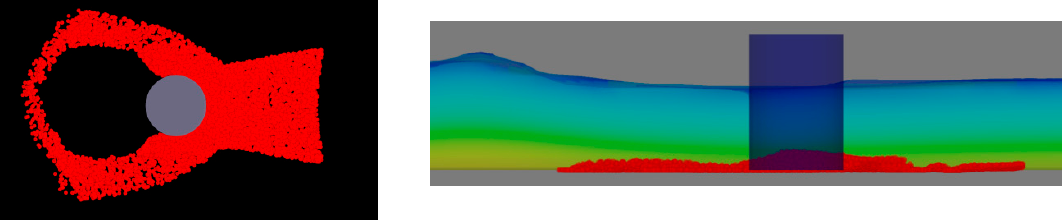
Figure 21. Plan and side view of the bed morphology after exposure to waves for 80 s (simple monopile).